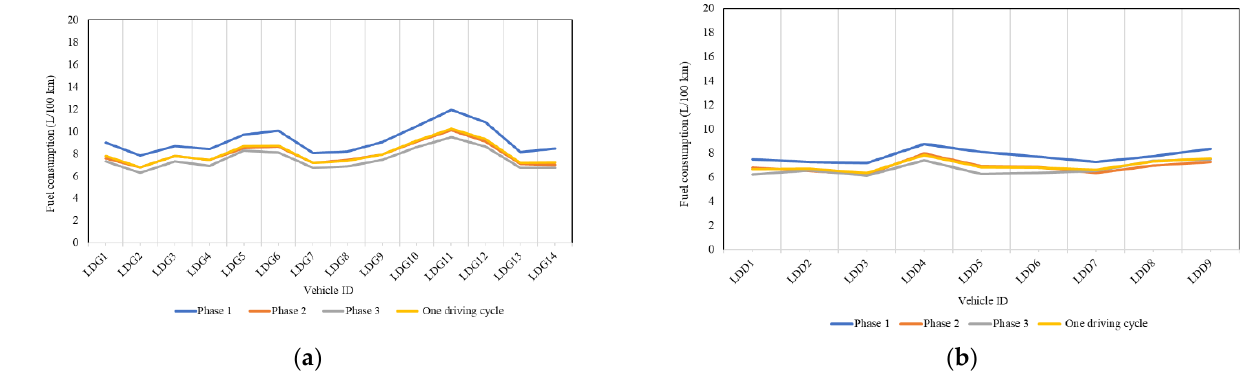
Figure 3. Fuel consumption rate (L/100 km) for ( a ) LDG and ( b ) LDD vehicles.